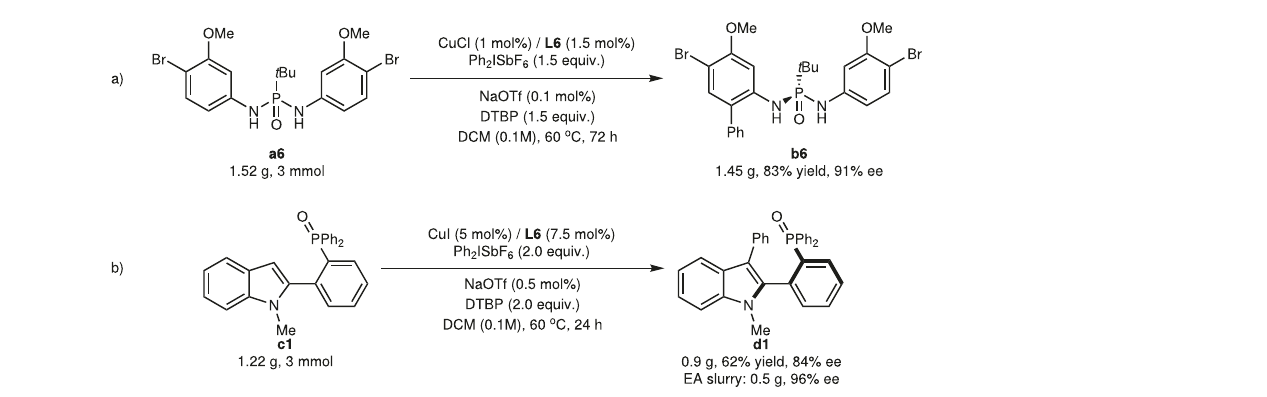
Fig.5|Substratescopewithdiaryliodoniumsaltsfordiphenylphosphineoxide indoles. Reaction conditions unless otherwise noted: c (0.10mmol), Ar 2 ISbF 6 (0.2mmol), CuI (0.01mmol), L6 (0.015mmol), NaOTf (0.001mmol), DTBP